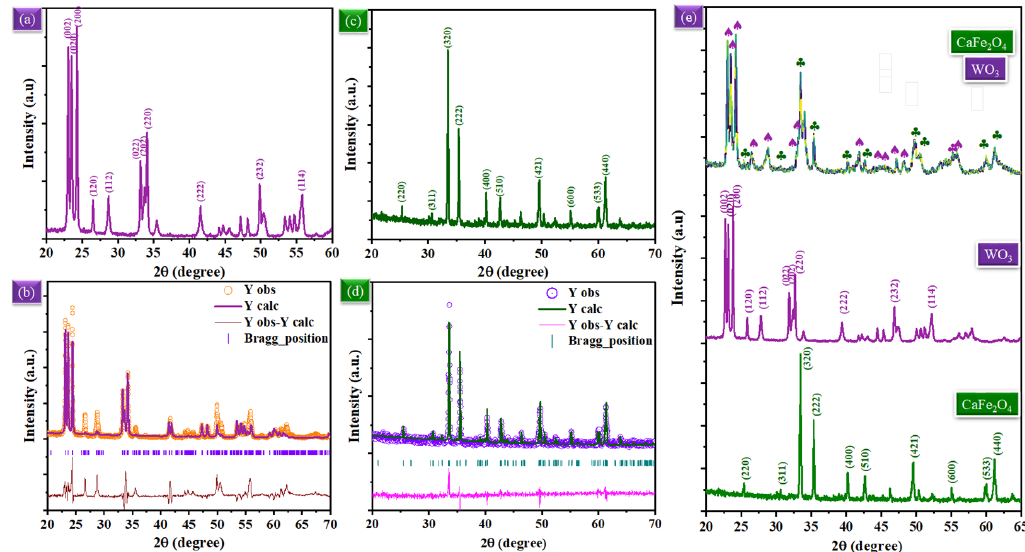
Figure 1. ( a , b ) measured and refined the estimated XRD data using Prof ‐ Suit software of WO3, ( c , d ) measured and refined the measured XRD data using Prof ‐ Suit software of CaFe 2 O 4 and ( e ) X ‐ ray diffraction pattern of WO 3 ‐ CaFe 2 O 4 heterostructure composite in ‐ comparison of individual WO 3 and CaFe 2 O 4, respectively.